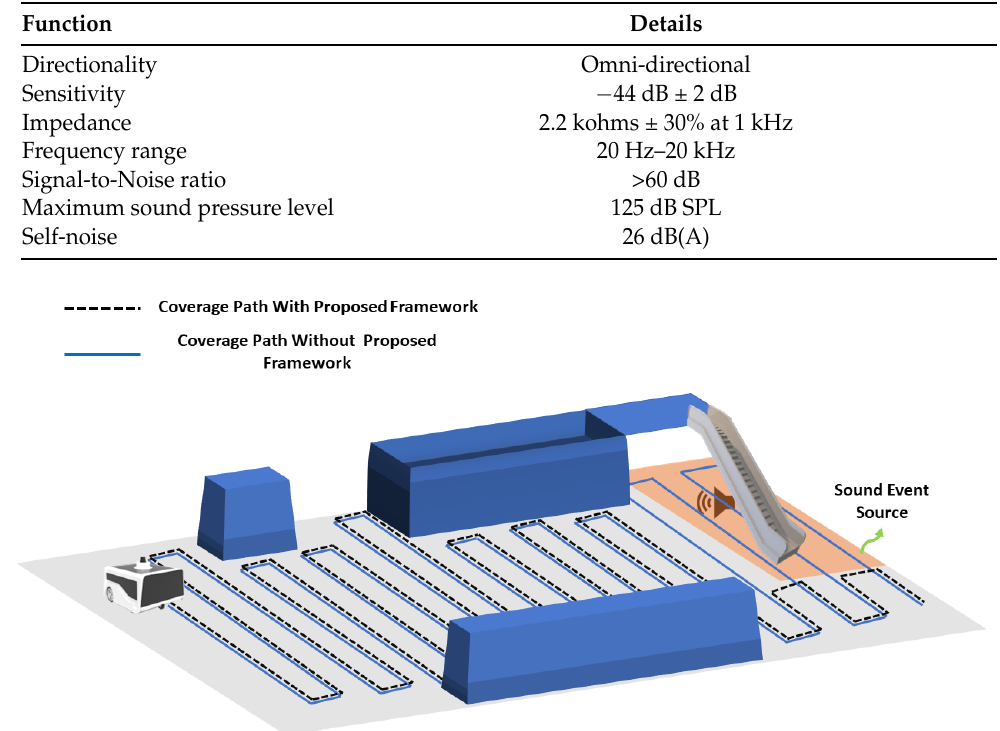
Table 1. Microphone specification.